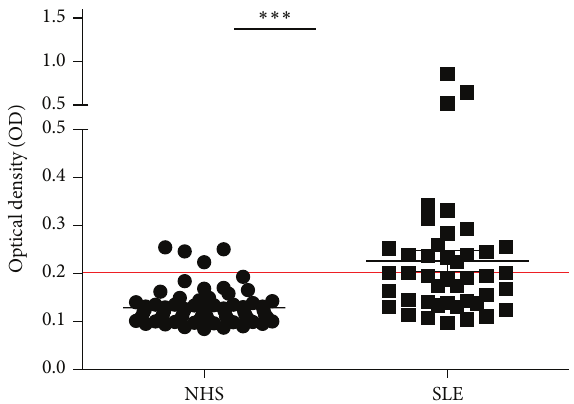
Figure 4: Titer of autoantibody against p53 in human sera by ELISA. The range of antibody titers to p53 was expressed as optical density (OD) obtained from ELISA. The mean + 2SD of NHS was shown in relationship to all serum samples. Titer of anti-p53 in SLE serum was much higher than that in NHS ( 𝑃 < 0.01 ). The cutoff value line for positive samples is indicated in the